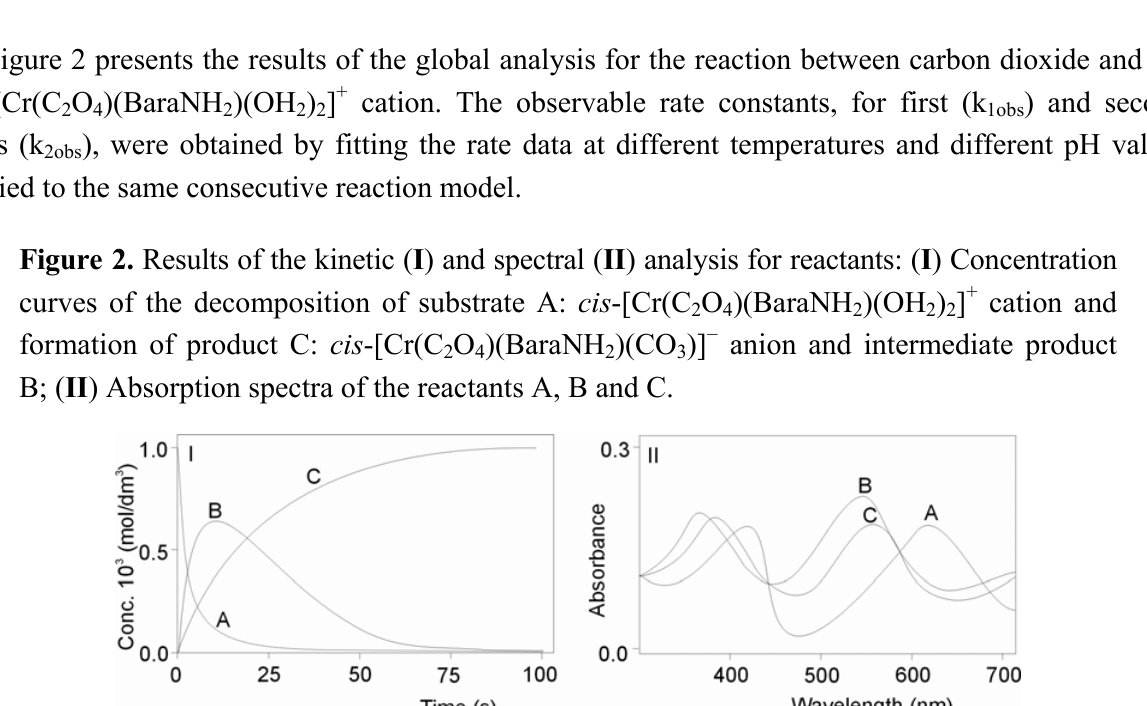
Table 1. Observable rate constants (k ) for the reaction of the carbon dioxide uptake by 1obs cis -[Cr(C O )(BaraNH )(OH ) ] + complex cation (first step) {[CO 2 4 2 2 2 NaClO 4